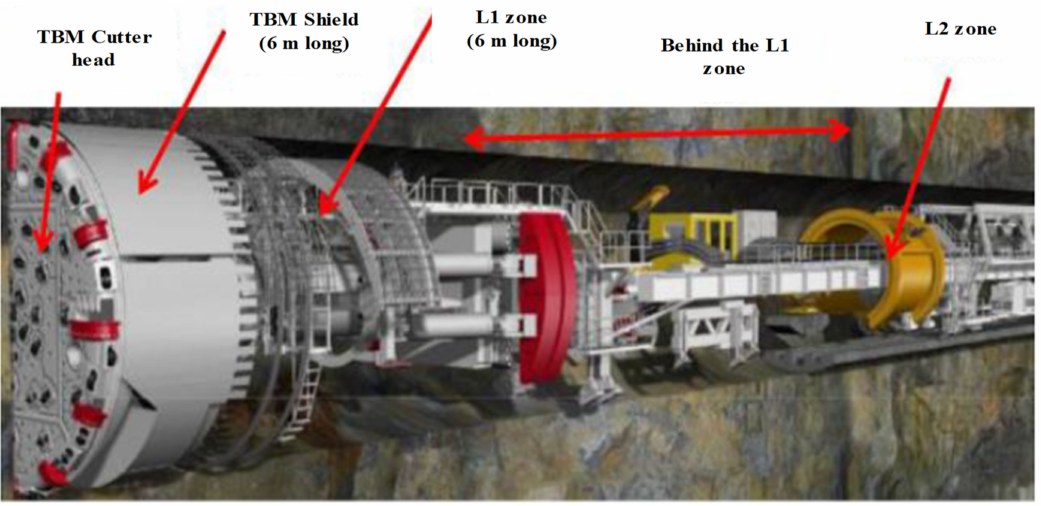
Figure 6. Open gripper tunnel boring